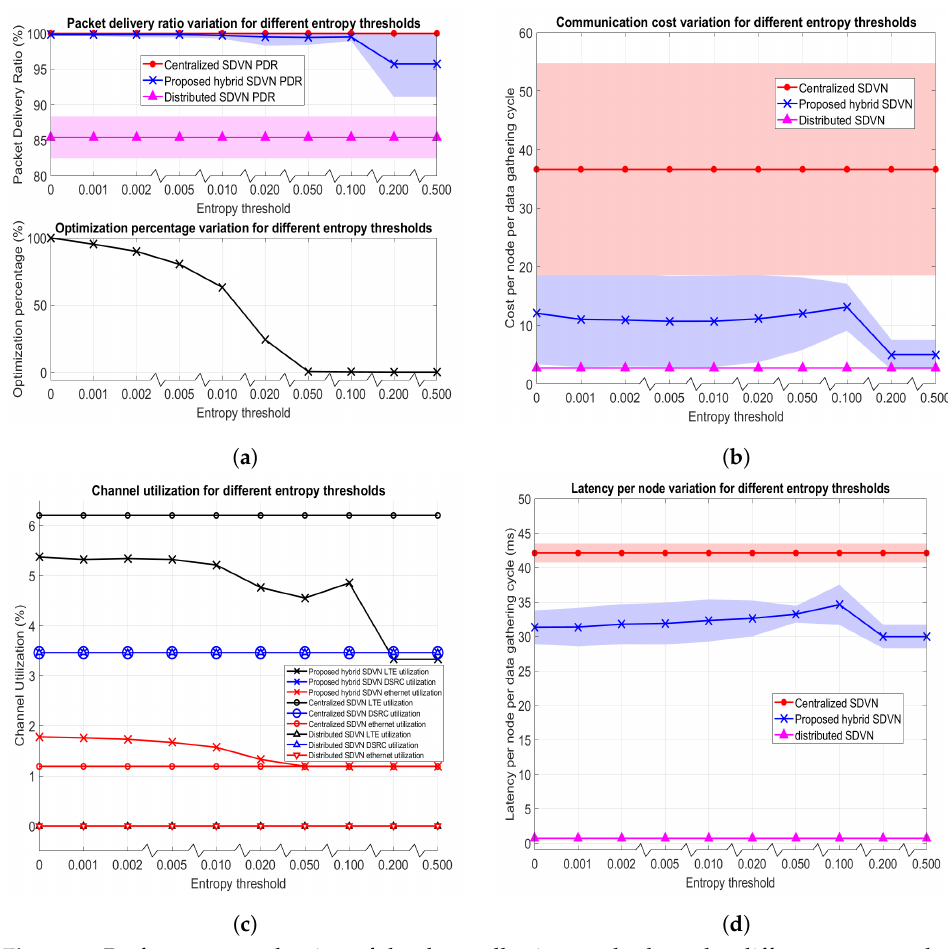
Figure 7. Performance evaluation of the data collection methods under different entropy thresh- old values. ( a ) Packet delivery ratio and optimization percentage variation for different entropy thresholds. ( b ) Communication cost per node per data-gathering cycle variation for different en- tropy thresholds; ( c ) Average channel utilization per data-gathering cycle variation for different entropy thresholds. ( d ) End-to-end latency per node per data-gathering cycle variation for different entropy